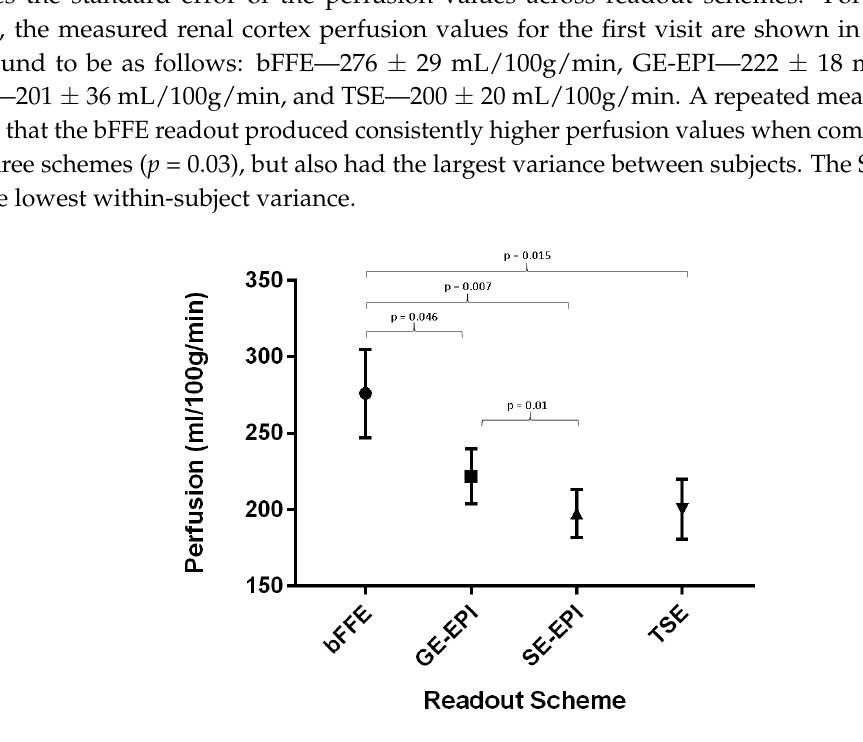
Figure 5. Renal cortical perfusion values measured from each readout scheme for the first visit. Values shown are the mean perfusion values with error bars showing the standard error of the mean. The bFFE readout gave significantly higher perfusion values than the other readouts (repeated measures ANOVA, p = 0.03). A significant difference was observed between SE-EPI and GE-EPI., with p -values of post-hoc paired t -tests shown.